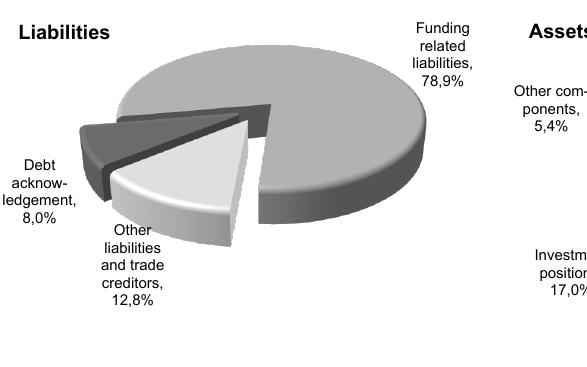
Composition of assets and